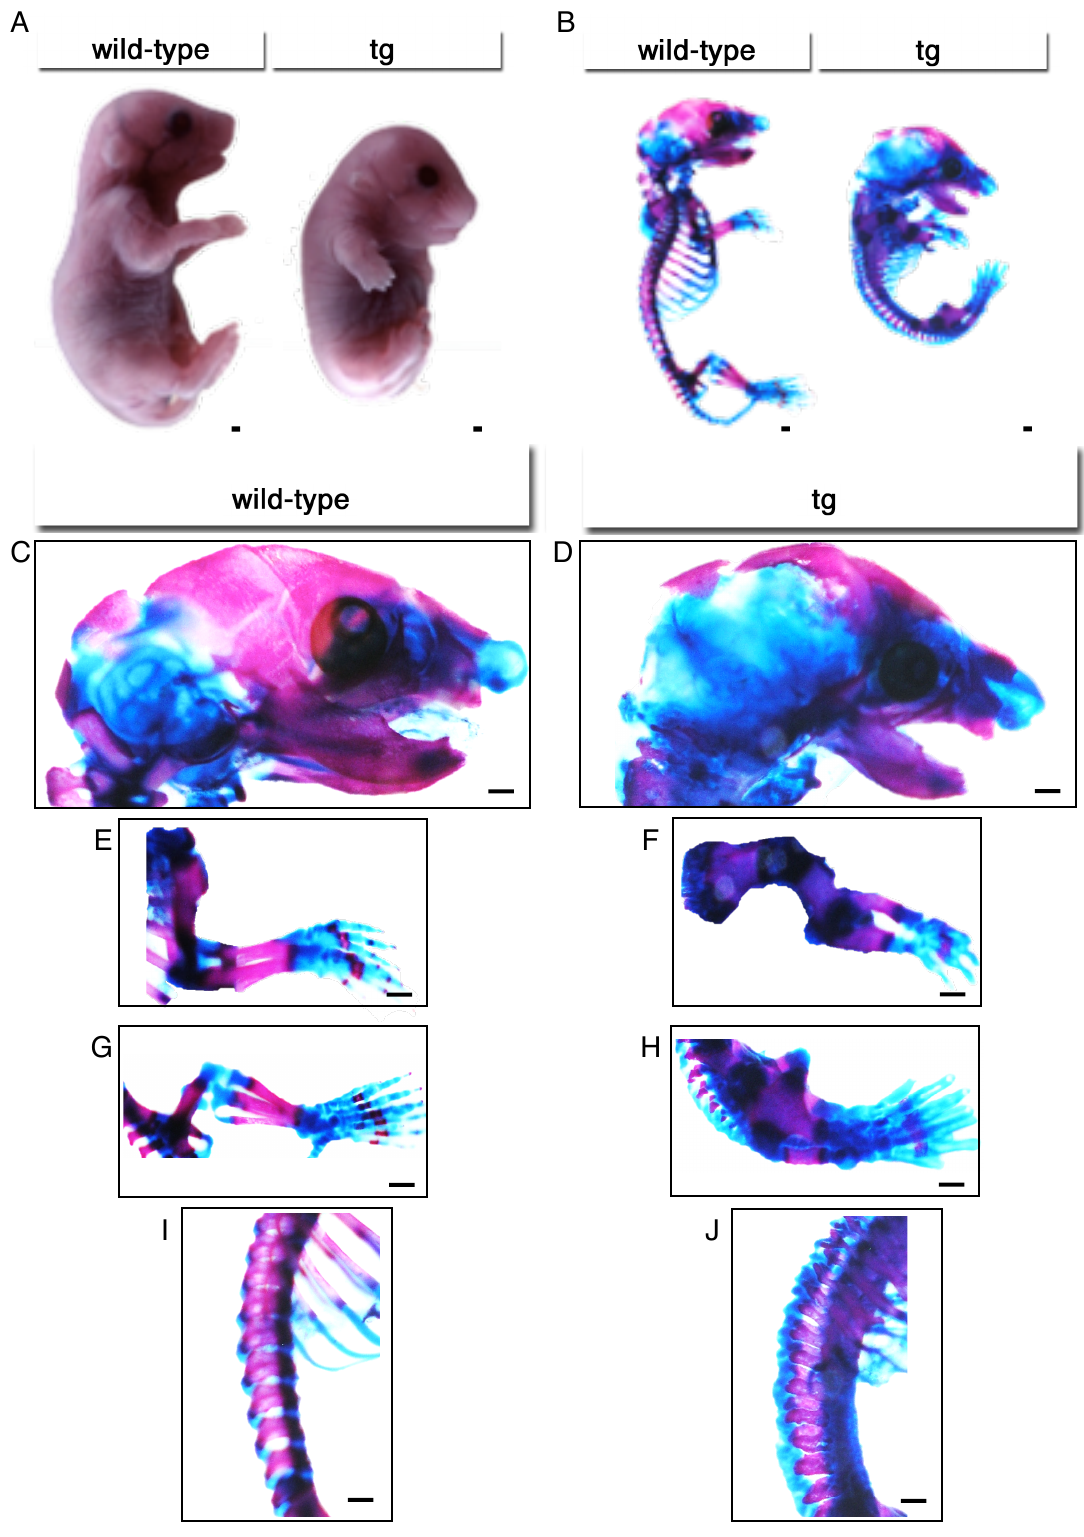
Figure 3. Skeletal system in Hck CA tg embryos at E18.5. ( A ) Physical appearance of wild-type and Hck CA tg embryos. ( B – J ) Skeletal system. The whole skeletons ( B ), and enlarged views of the head ( C , D ), forelimbs ( E , F ), hind limbs ( G , H ), and vertebrae ( I , J ) in wild-type and Hck CA tg embryos. Scale bars: 1.25